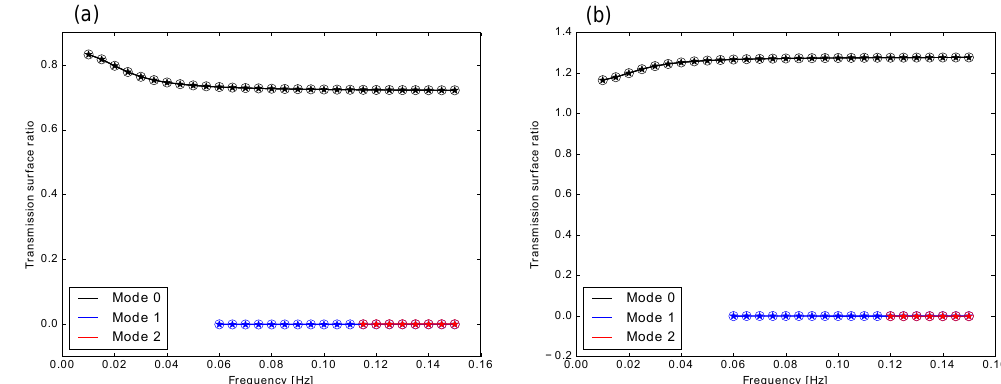
Figure 6. Transmission surface ratios for an incident Love wave fundamental mode propagating in the forward direction (a) and backward direction (b) in the Sato model. Shown are results from the GAl method (solid lines), the GF method (circles) and the method of Alsop (stars). Even though higher modes exist in the model at the frequencies considered and SWRT by default computes coupling to all modes that exist at any given frequency, all three methods exactly predict that there is no mode